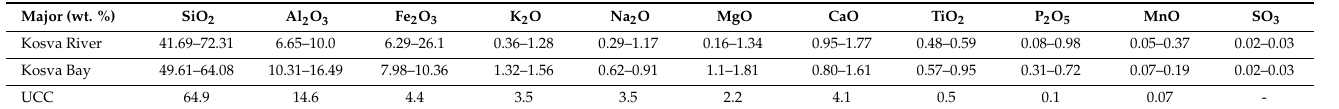
Table 4. Comparison of the chemical composition of sediment samples from this study with the upper continental crust (UCC)